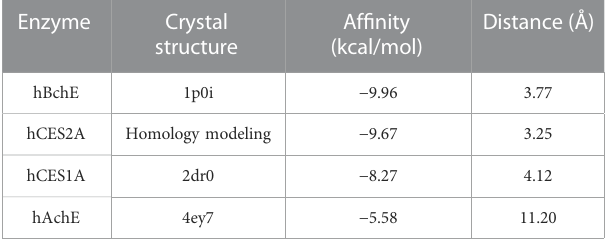
TABLE 4 The molecular docking simulations of AB23A towards hBchE, hCES2A, hCES1A, hAchE. Enzyme Crystal